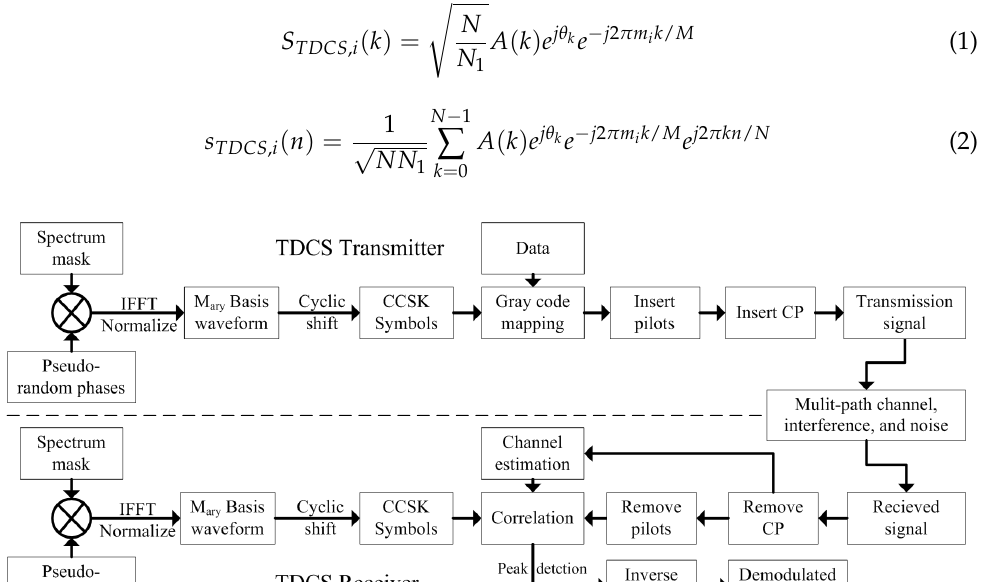
Figure 1. The diagram of TDCS.